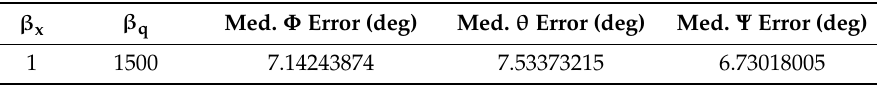
Table 11. Euler angle errors of the weighted Euclidean-based model (150,000 iterations).